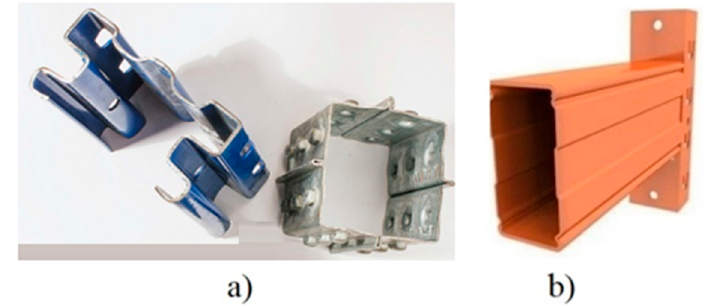
Figure 2. Typical cross-sections: ( a ) uprights and ( b ) beams.